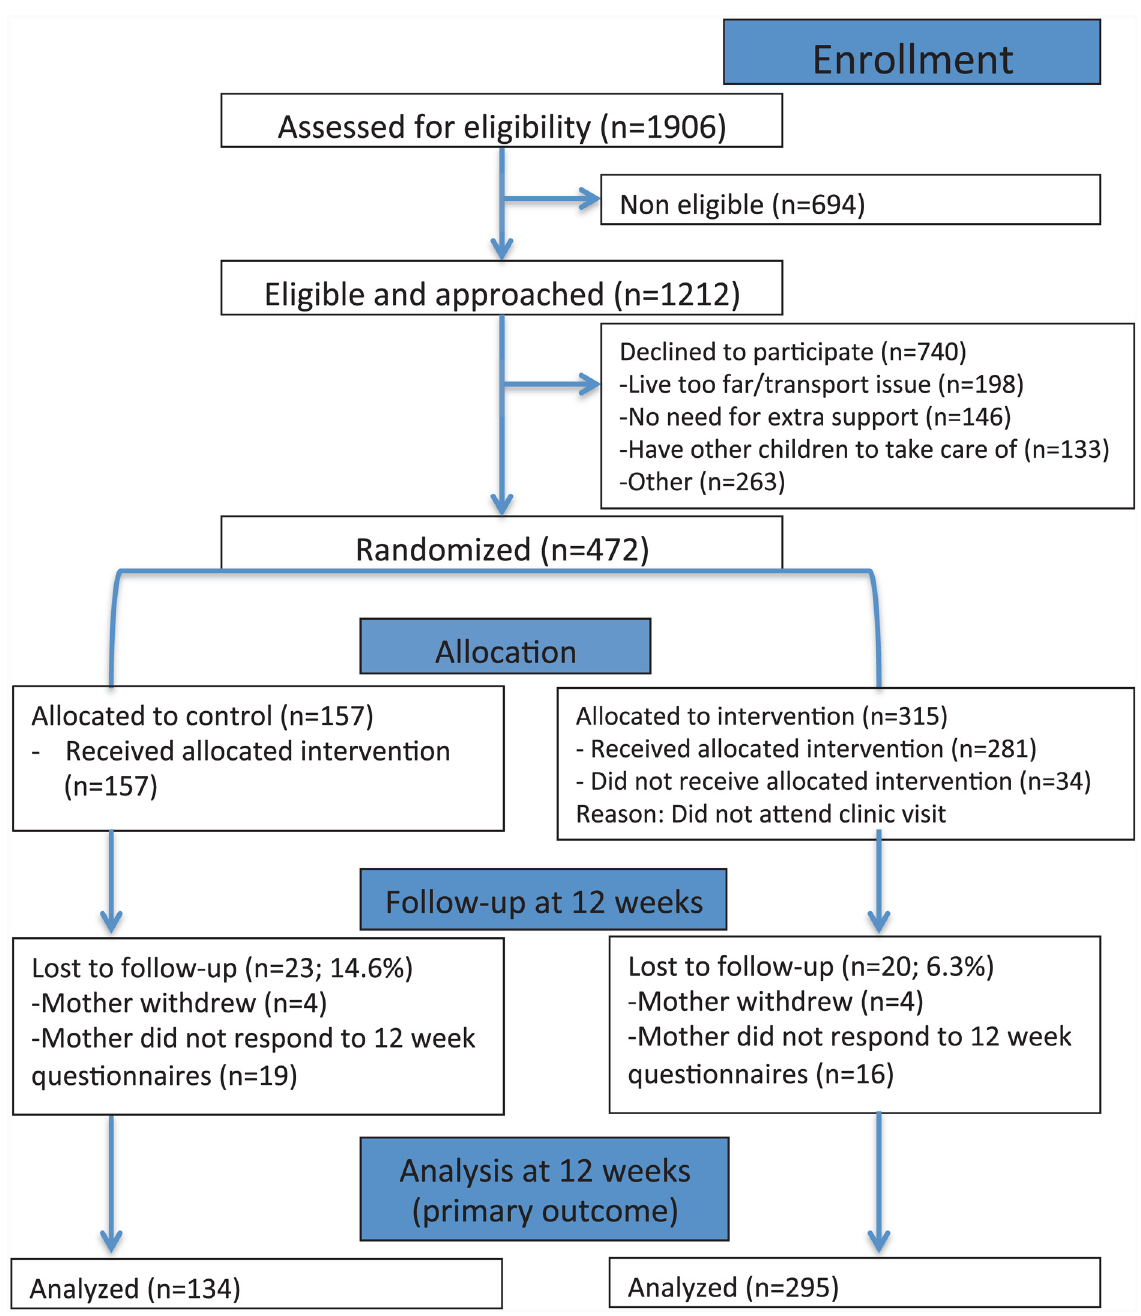
Fig 1. Flowchart of eligible and consented